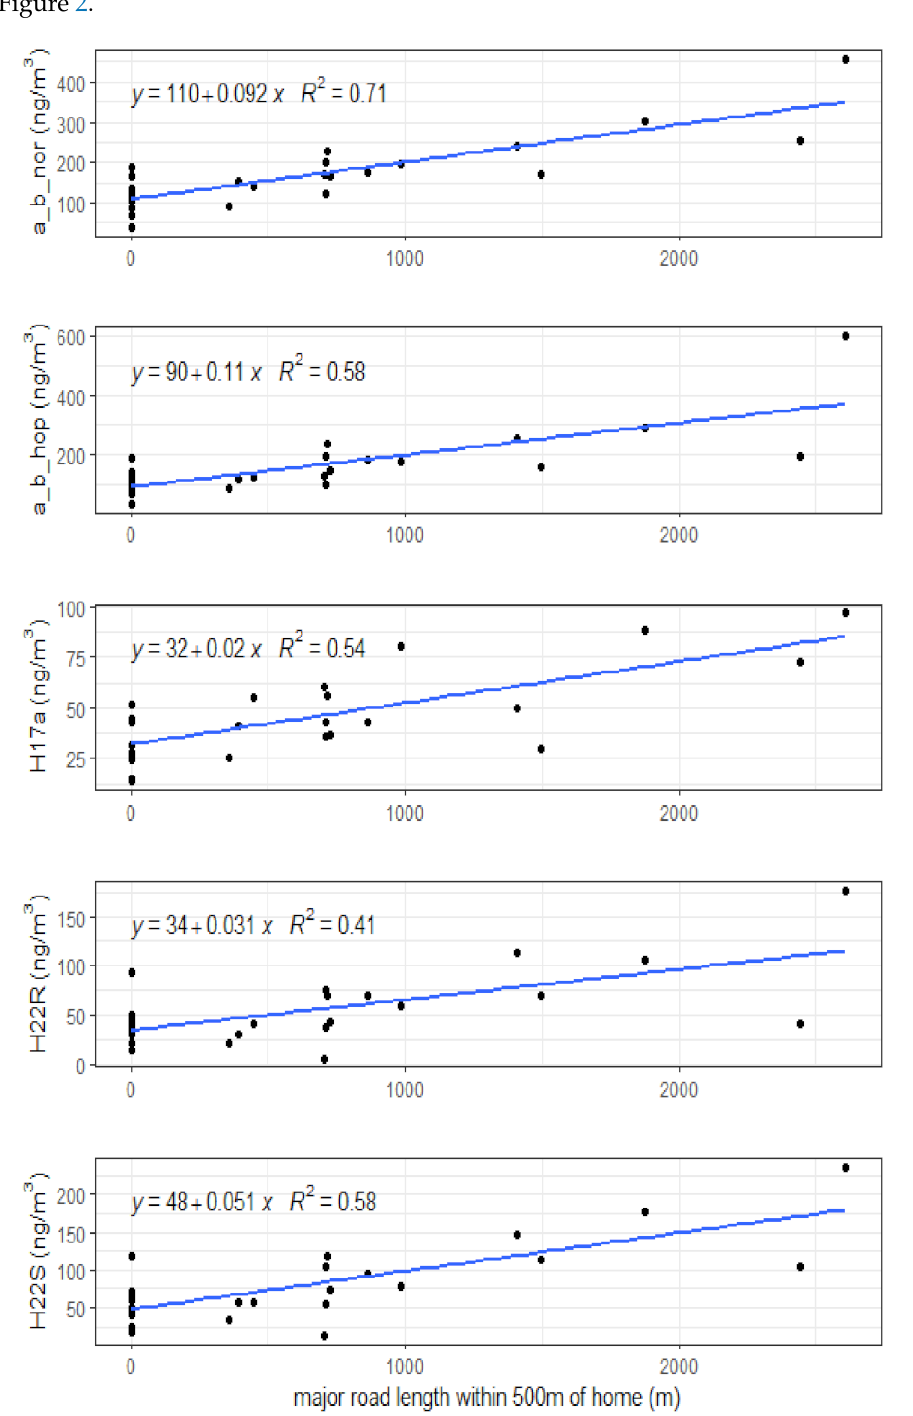
Figure 2. Summer hopanes: LSR models for personal summer hopanes and length of major roads within 500 m of participant